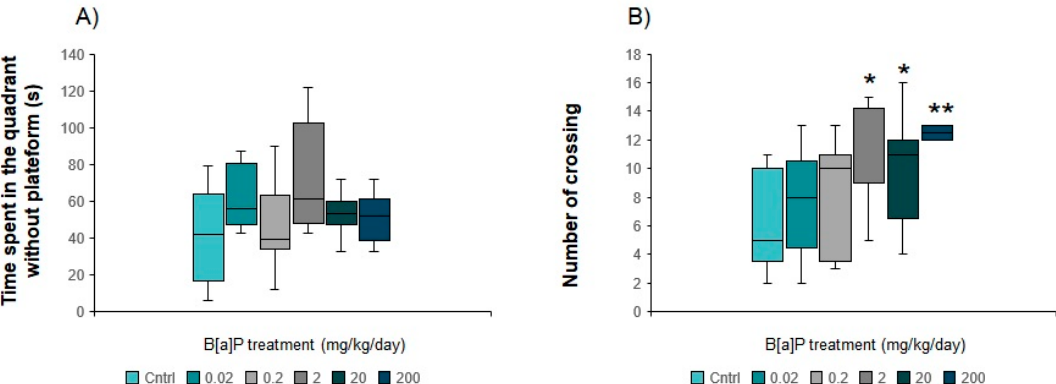
Figure 8. Performances of the sixth trial of B[a]P-exposed mice via oral gavage at doses ranging from 0.02 to 200 mg/kg for 10 consecutive days in the Morris water maze. ( A ): Time spent in the quadrant without plateform, ( B ): Number of crossing. Data from 10 mice per group are expressed as the median (central line); boxplot represents the 1st (25) and 3rd (75%) quartiles; minimum and maximum values observed are represented by error bars. * p < 0.05, ** p < 0.01, (MW-U test for multiple comparisons).